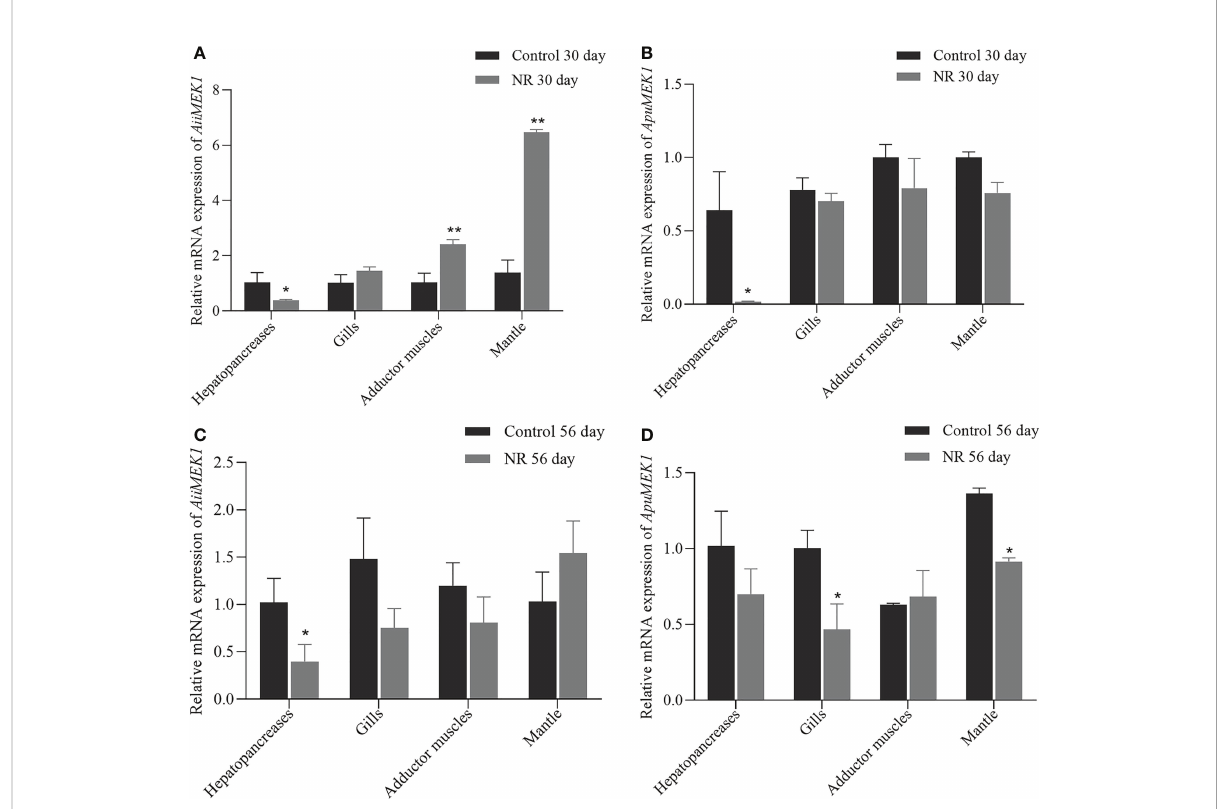
FIGURE 8 Expression of MEK1 on Day 30 and Day 56 in the dietary restriction group and the control group in Airradians (A, B) and A purpuratus (C, D) (* p < 0.05 and ** p<0.01).